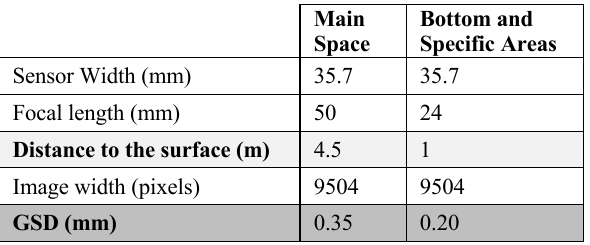
Table 1 . GSD calculations for terrestrial photogrammetry. Table by CIMS © GCI 2019.